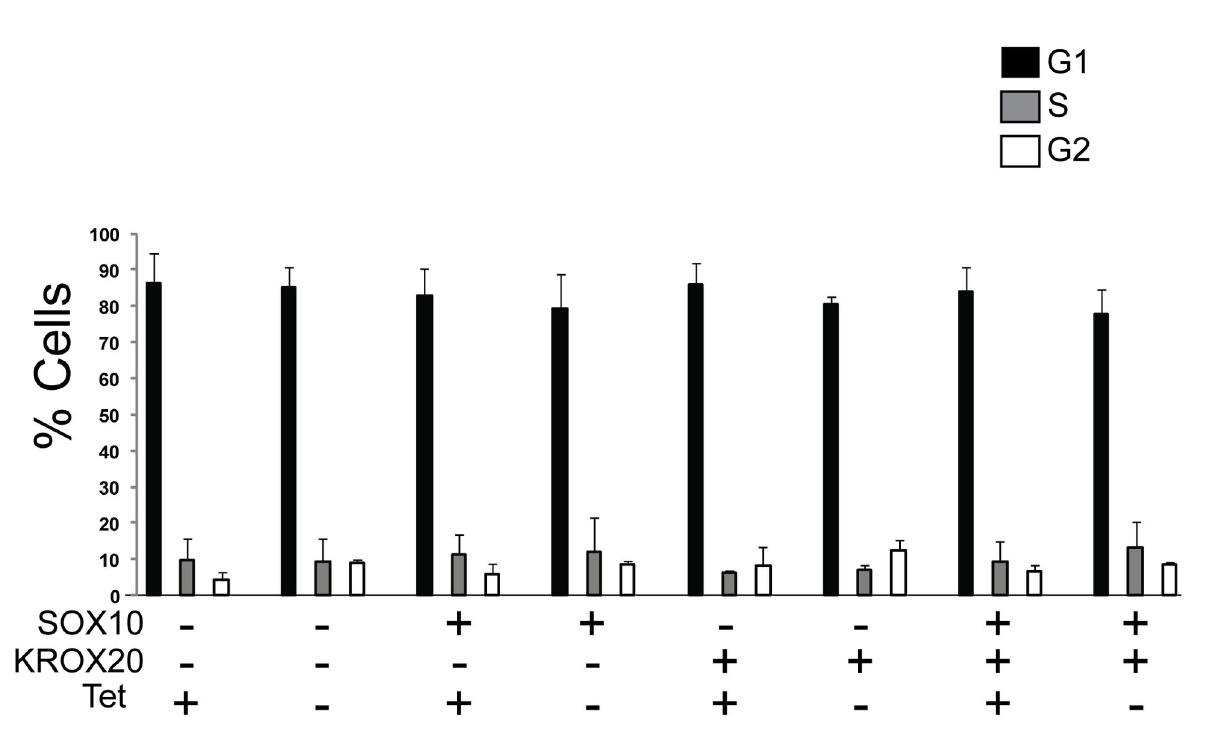
Figure 3. FACS analysis of differentiated B22 cells. B22 cells were infected with an empty vector, pBabe-SOX10, pBabe- KROX20, or pBabe-SOX10 together with pBabe-KROX20 in the presence or absence of tetracycline and differentiated in low serum media. Propidium iodine stained samples were FACS sorted and analyzed using Cell Quest Pro (BD Biosciences). The data are the average of three independent experiments. Standard error bars are